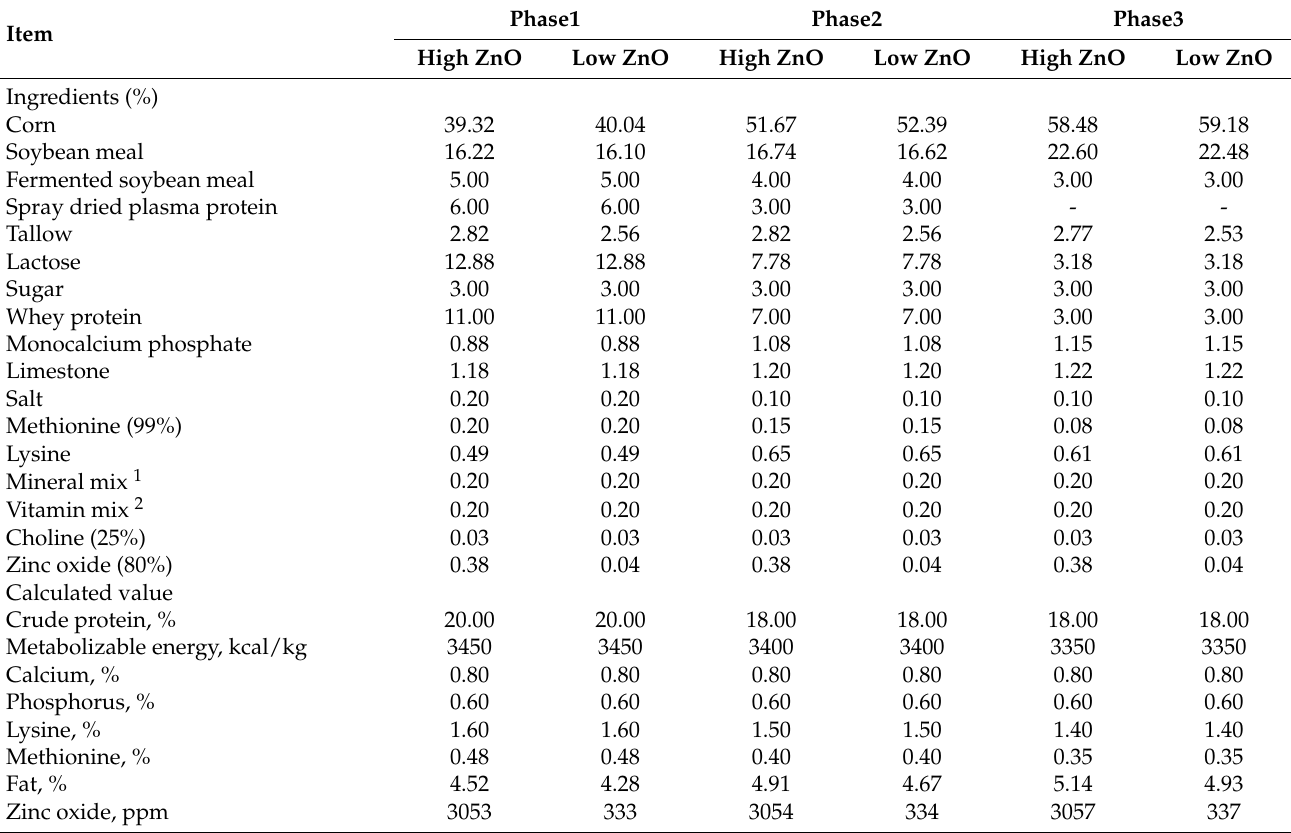
Table 1. Composition of weaning pig diets. (as